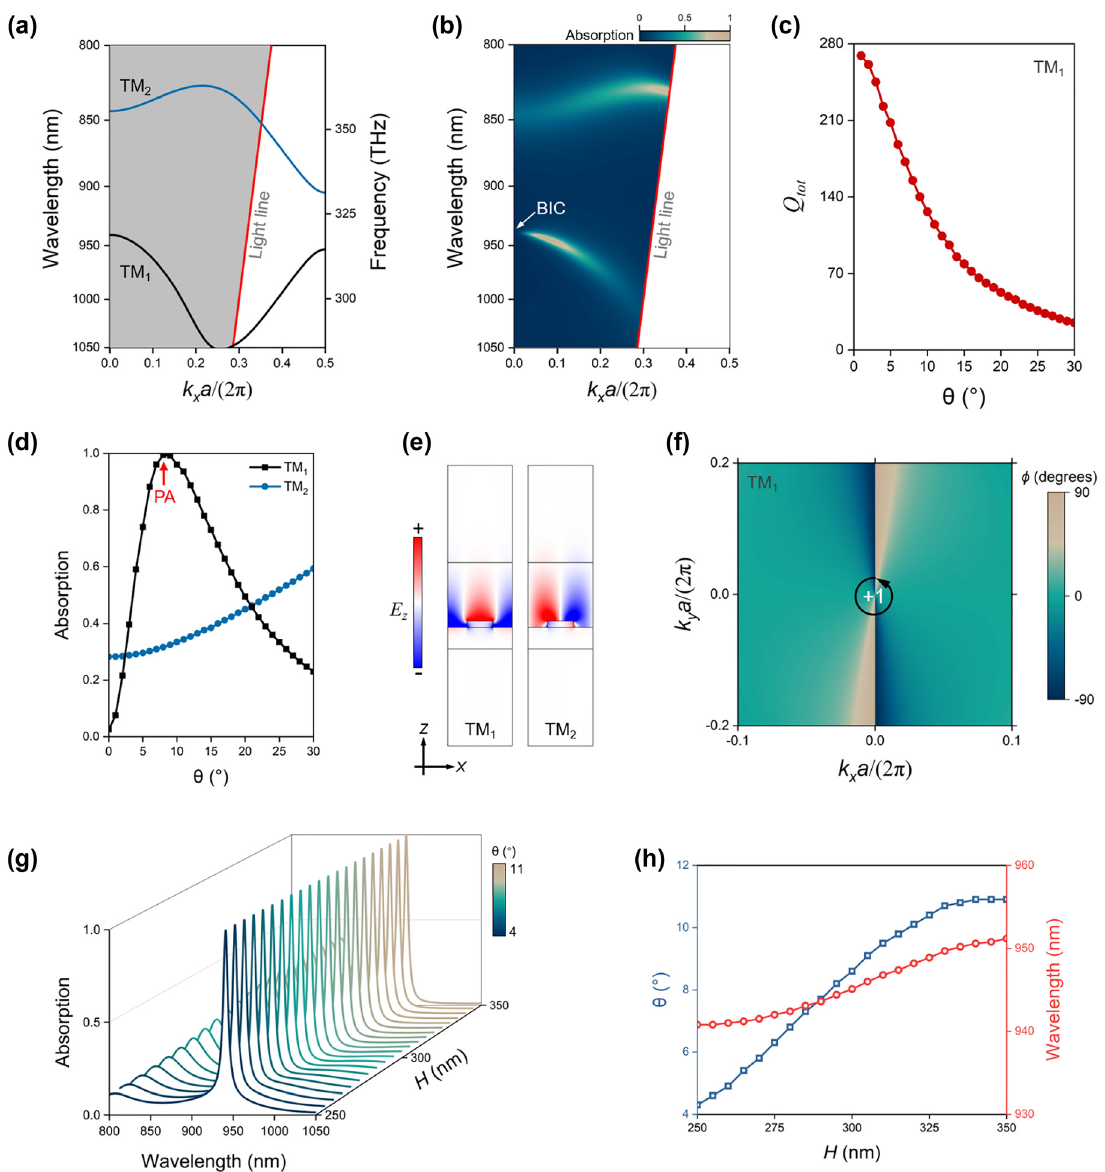
Figure 2: BIC in plasmonic grating structure. (a) The band structure of plasmonic structure. (b) Angle-resolved absorption spectra under TM polarization. BIC can be found in TM 1 mode at normal incidence. (c) Dependence of the Q factor of TM 1 mode on the angle of incidence. (d) Absorption of TM 1 and TM 2 modes for different angles of incidence. (e) Electric- fi eld E z pro fi les of the BIC (TM 1 ) and leaky (TM 2 ) mode. (f) The angle of the polarization vector of TM 1 mode in k space. BIC is protected by a topological charge q = + 1 at Γ point. (g) Absorption spectra of plasmonic structure with different H . (h) Incident angle and wavelength of the PA for different H